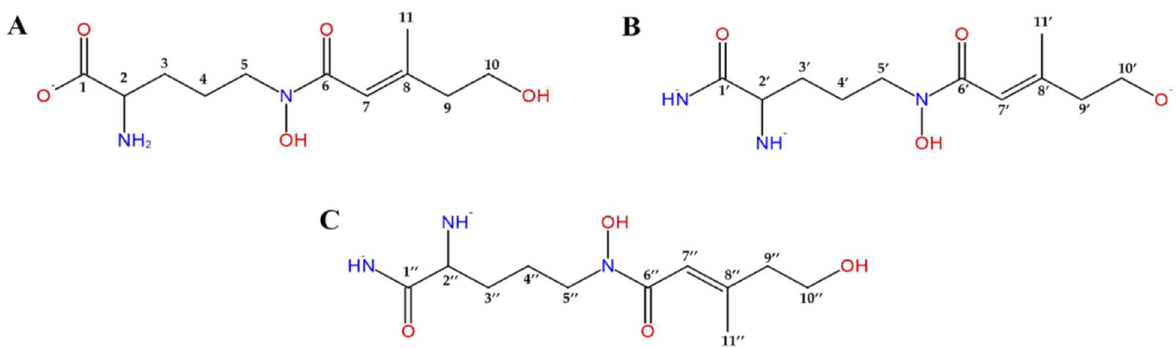
Figure 6. Three fragment structures of coprogen ( B ) are investigated by 1 H-NMR and 13 C-NMR spectroscopy. Fragment ( A ) is linked to fragment ( B ) via an ester group. Then, fragments ( B ) and ( C ) are linked through the amide group.